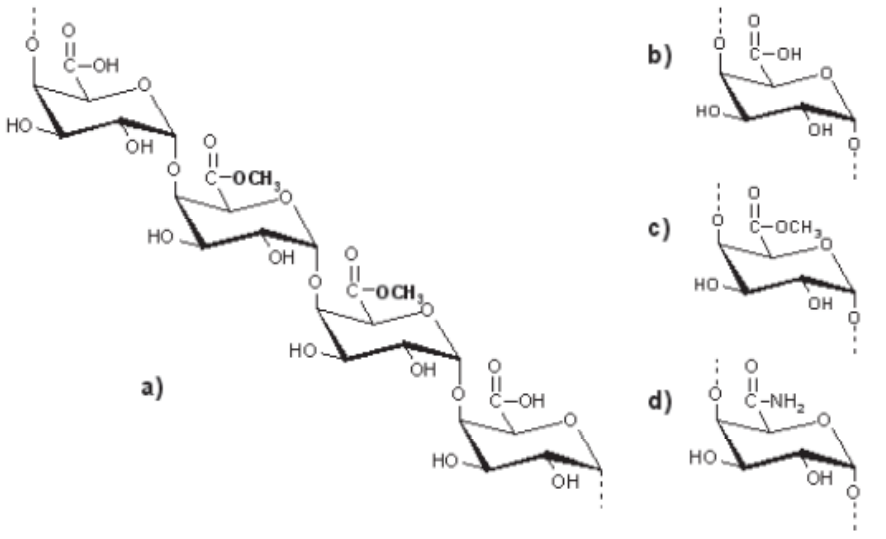
Figure 7. ( a ) A repeating segment of pectin molecule and functional groups; ( b ) carboxyl; ( c ) ester; ( d ) amide in pectin chain